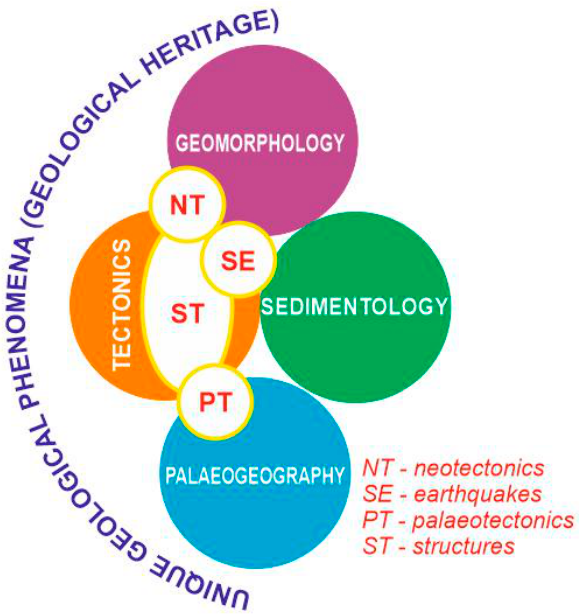
Figure 4. Conceptual representation of some principal tectonics-related constituents of geological heritage.